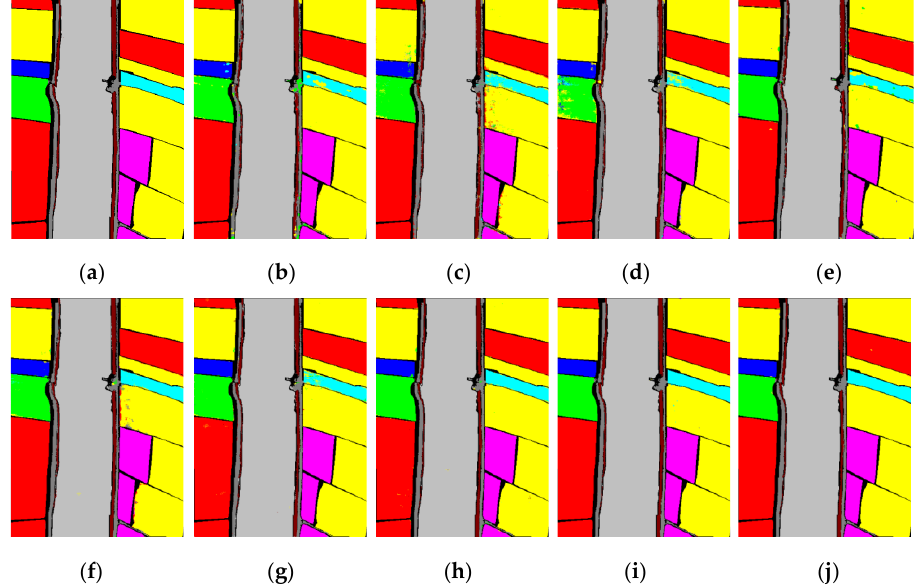
Figure 10. The classification results of LongKou dataset. ( a ) Ground Truth; ( b ) RBF-SVM; ( c ) EMP- SVM; ( d ) CNN; ( e ) ResNet; ( f ) MLP-Mixer; ( g ) RepMLP; ( h ) DFFN; ( i ) DMLP; ( j ) DMLPFFN. The color and edge features extracted from the low-level branch enable one to distin- guish more conveniently between different types of crops and amplify the differences be- tween different crops, whereas the regional features extracted in the middle-level branch lead to more apparent boundaries between crops in different places and perform better identification of crop areas and non-crop areas. The global features extracted at the high level minimize the clutter between sophisticated backdrops and crops to a certain extent and provide a better assessment of the overall crop area. Multi-level feature fusion can sufficiently extract and leverage the feature information of crops and fine classifications of them. Consequently, DMLPFFN is considered suitable for fine crop classification. 5. Discussion In order to find the optimal network structure, it is necessary to experiment with different parameters, which play a crucial role in the size of the model and the complexity of the proposed DMLPFFN. In this paper, the optimal parameter combination is deter- mined by analyzing the influence of parameters on the accuracy of classification results, including the number of PCAs, the expansion rate of dilated convolution, the percentage of training samples and the number of branches in the feature fusion strategy. 5.1. The Number of Principal Components The first parameter is the number of principal components selected for PCA on HSI, which is used to extract the main spectral components to improve the algorithm’s effi- ciency and reduce noise interference. In the case of principal component number, the con- trol variable method is used for all datasets in the experiment. That is to say, the value of training sample number, expansion rate and deep feature fusion strategy is fixed. As shown in Figure 11, OA increased and then tended to be stable with the increase of the principal component number for the four HSI datasets. Most of the information in the hyperspectral image exists in the first few principal components. However, it was con- cluded that using many principal components did not further improve performance.